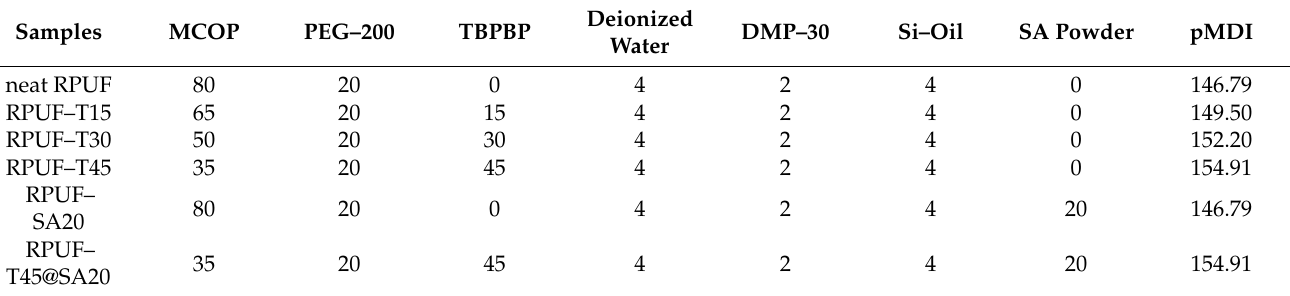
Table 1. The formulation of